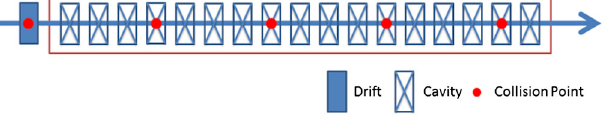
FIG. 3. A schematic plot of layout of the collision points in the linac.